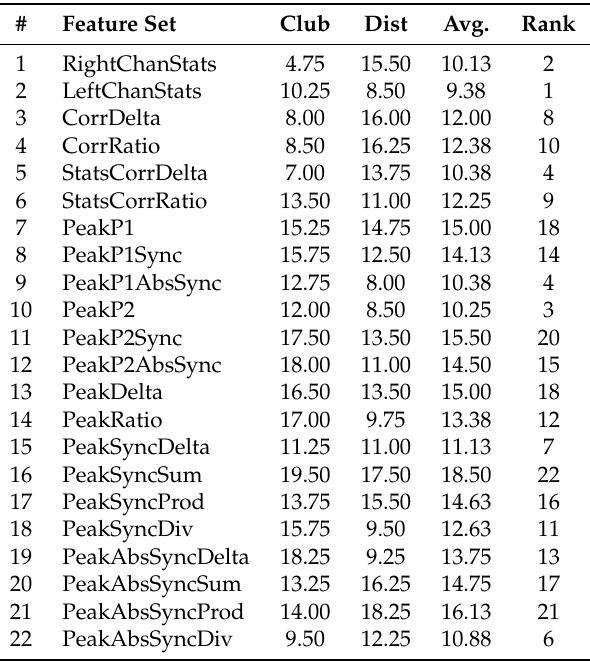
Table B3. Ultimate ranking of feature sets for the prediction of golf shot